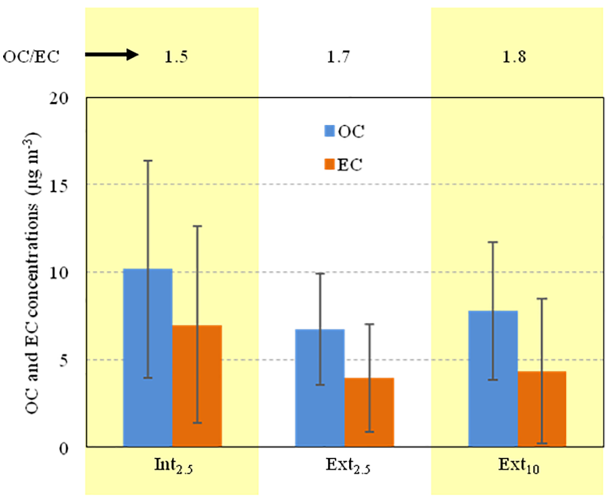
Figure 4. Carbonaceous species concentrations for all